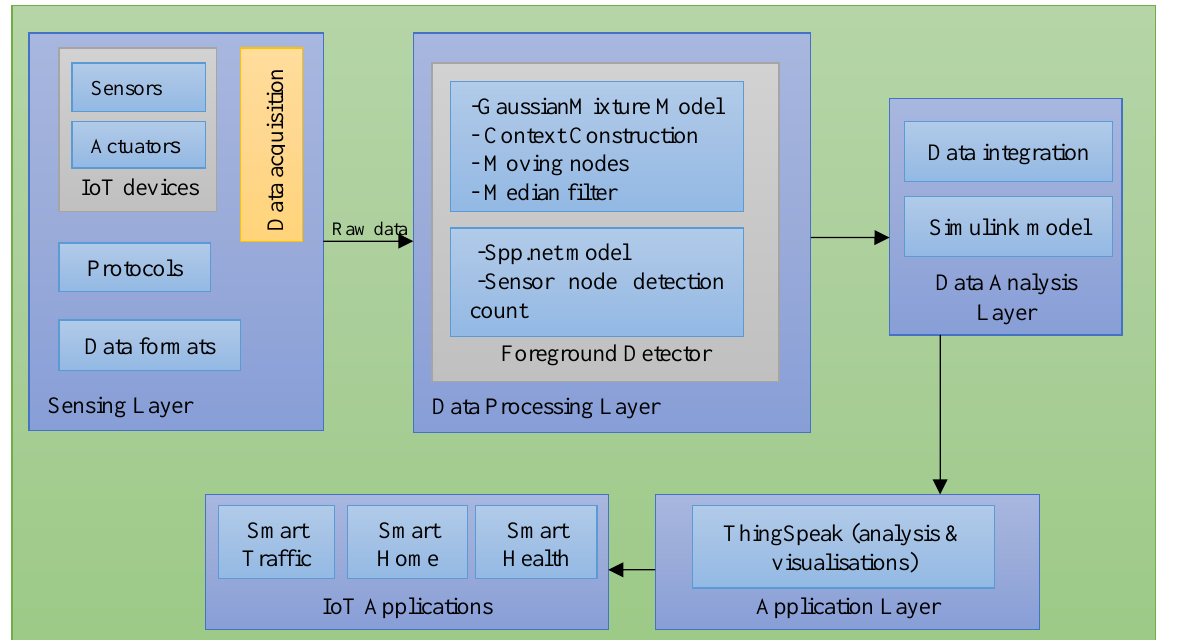
Figure 1. The proposed framework for IoT sensor data